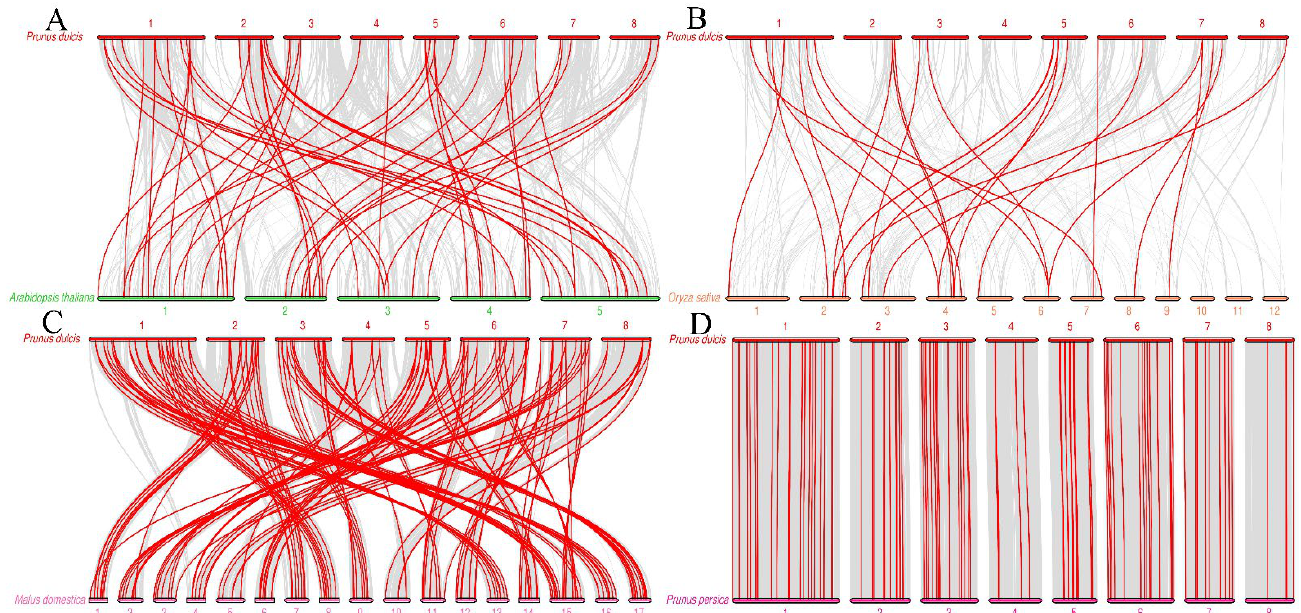
Figure 5. Synteny analysis of AP2/ERF family members in almond compared to those from four other plant species. ( A ) Prunus dulcis vs. Arabidopsis thaliana , ( B ) Prunus dulcis vs. Oryza sativa , ( C ) Prunus dulcis vs. Malus domestica , and ( D ) Prunus dulcis vs. Prunus persica . Each horizontal line represents a chromosome, and the red lines represent collinear genes. Eight chromosomes of Prunus dulcis are represented by red segments. Five chromosomes of Arabidopsis thaliana are represented by green segments. Twelve chromosomes of Oryza sativa are represented by yellow segments. Seventeen chromosomes of Malus domestica are represented by light pink segments. Eight chromosomes of Prunus persica are represented by pink fragments. The number represents the corresponding chromosome name.